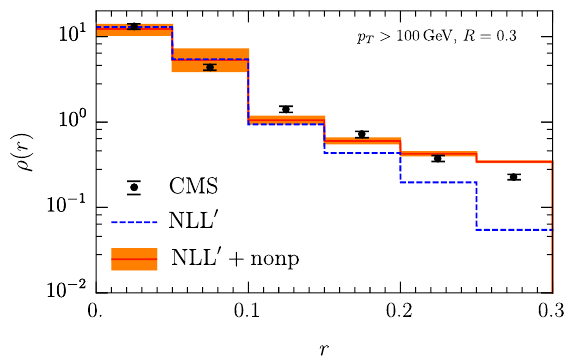
Figure 14 . Comparison of the di(cid:11)erential jet shape (cid:26) ( r ) and the CMS data of ref. [23]. The jets are obtained using anti-k T with R = 0 : 3, p T > 100 GeV, 0 : 3 <